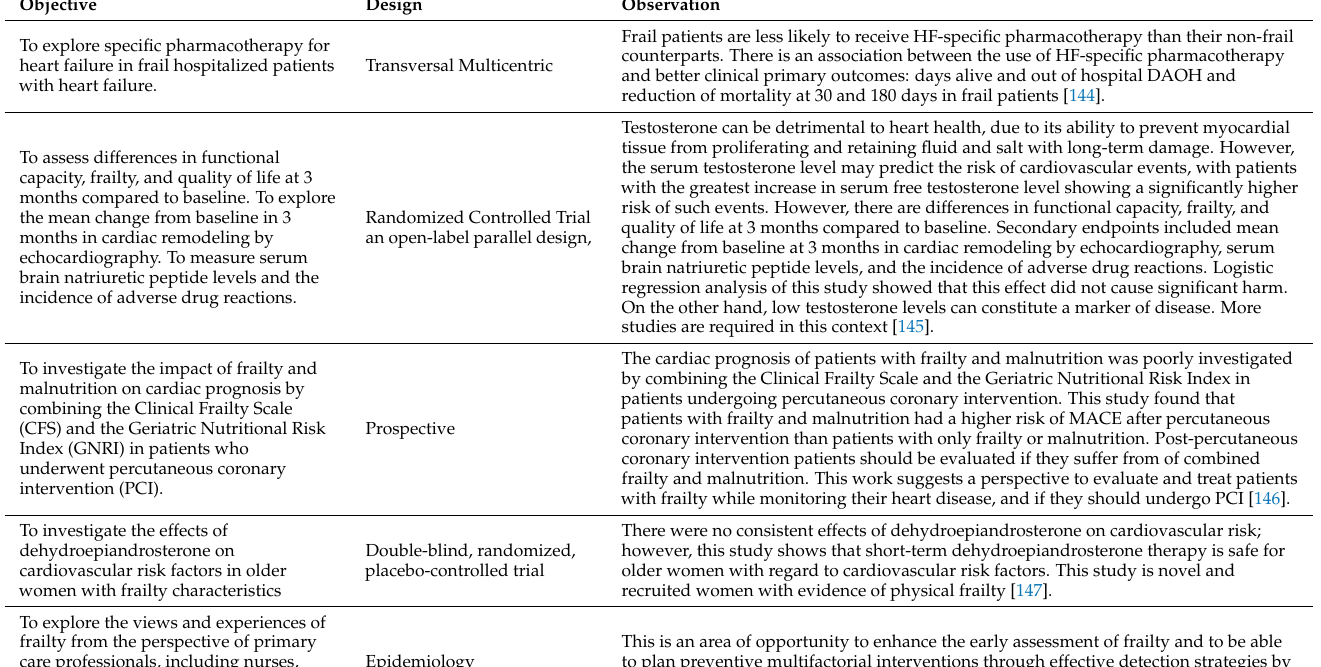
Table 2. Summary of studies on the treatment of frailty and analysis of perspectives in cardiovascular disorders in patients with